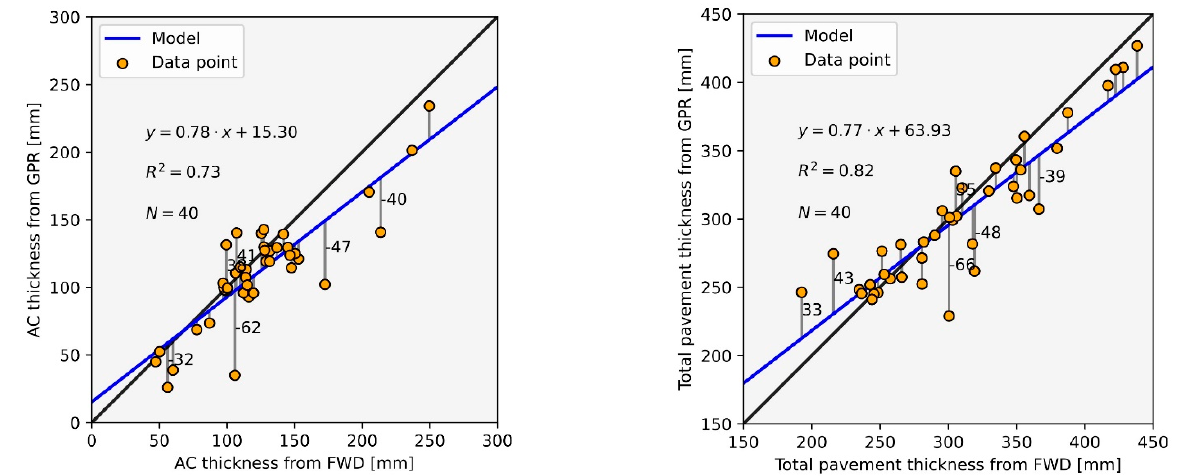
Figure 19. Verification of the current thickness prediction method using GPR data.